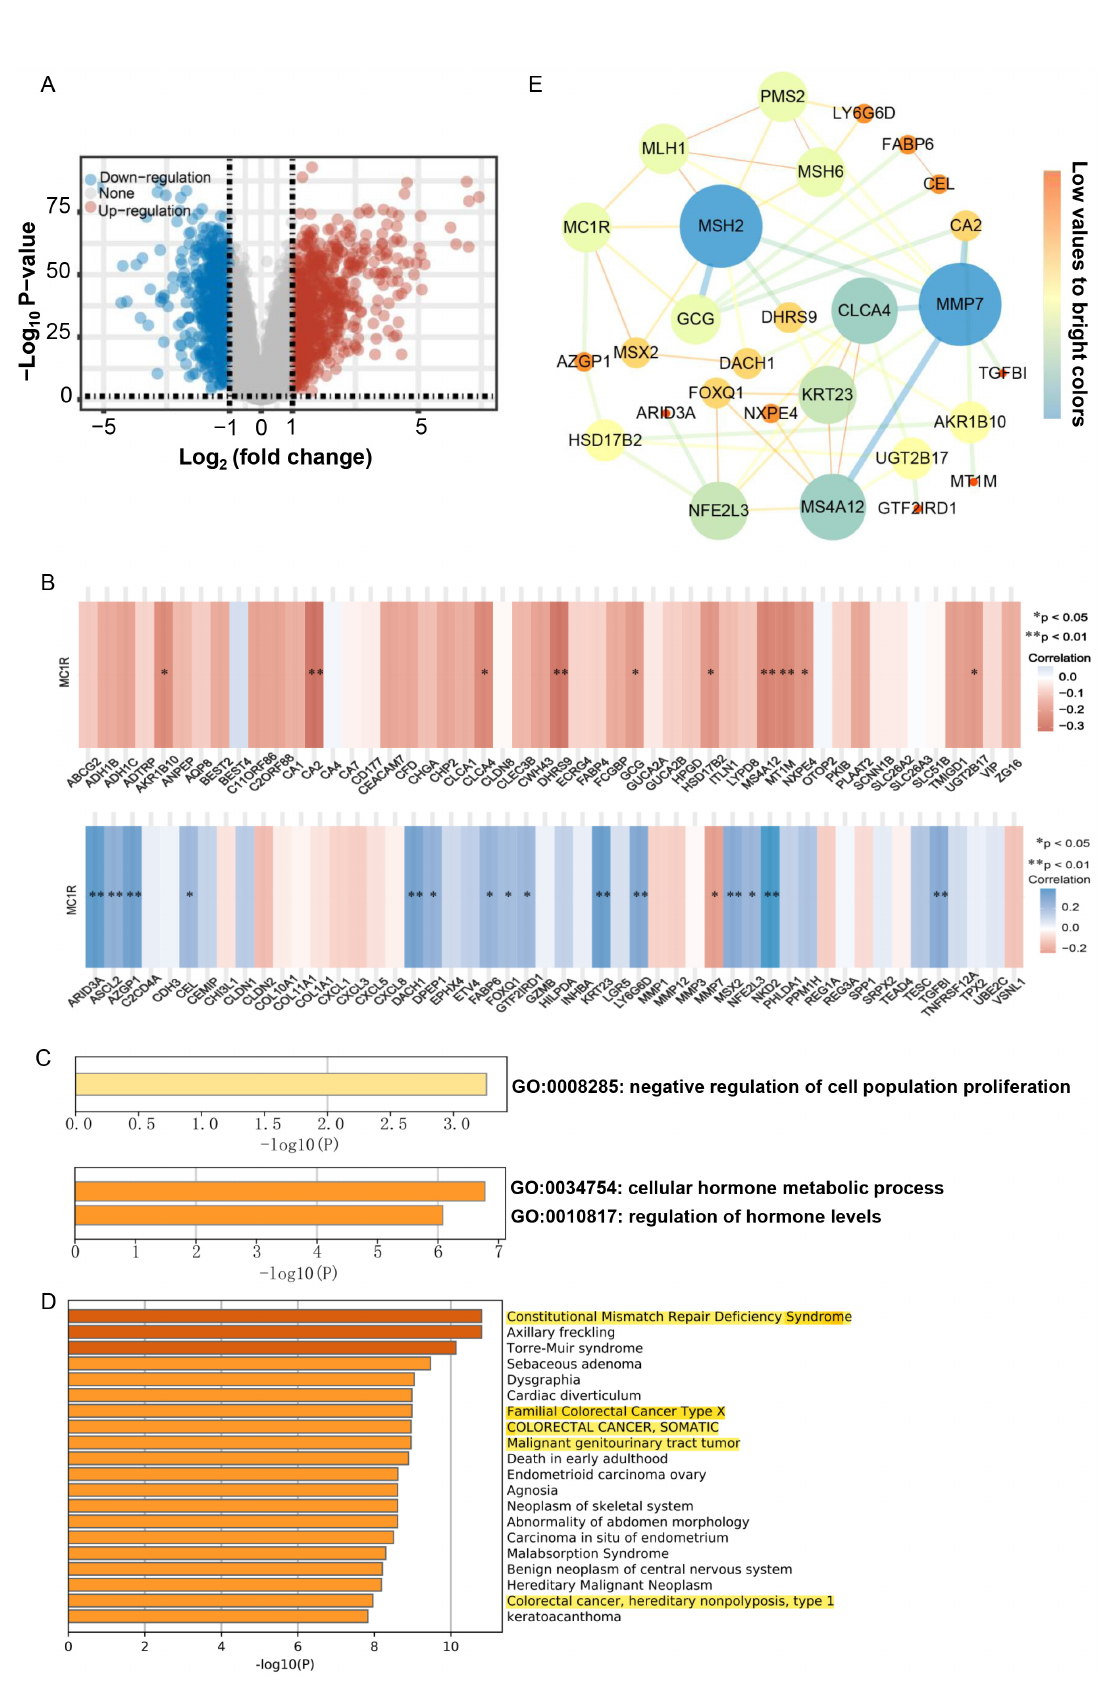
Figure 7. Gene Set Enrichment Analysis of MC1R in CRC. ( A ) Volcano plots were constructed using fold-change values and adjusted P. ( B ) Heat map of the correlation between MC1R and differential genes. The correlation between MC1R and the 50 upregulated genes with the largest difference change (above). The correlation between MC1R and the 50